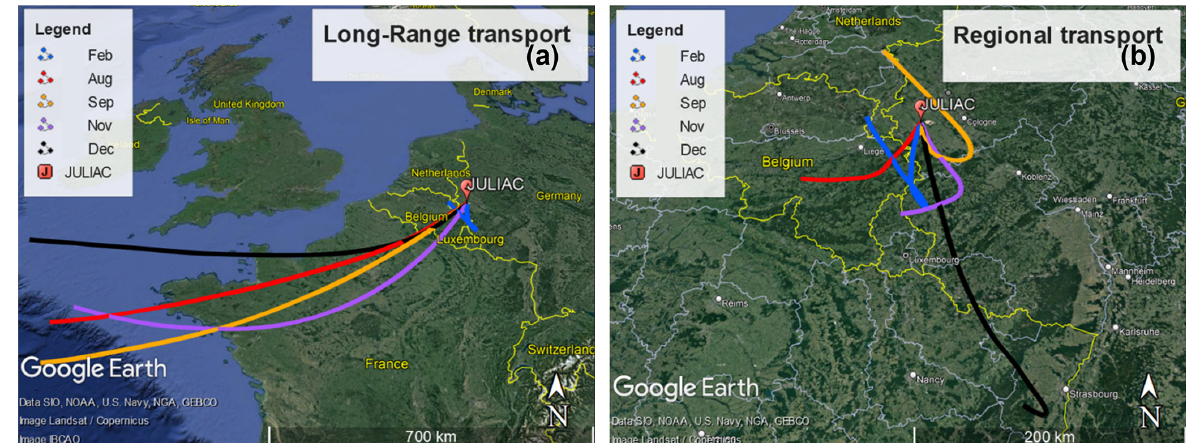
Figure 2. Results of the HYSPLIT cluster analysis of 48h back-trajectories for the different measurement periods. (a) Trajectories from air masses originating from long-range transport for each period. (b) Trajectories from air masses from regional transport. © Google Maps 2022.